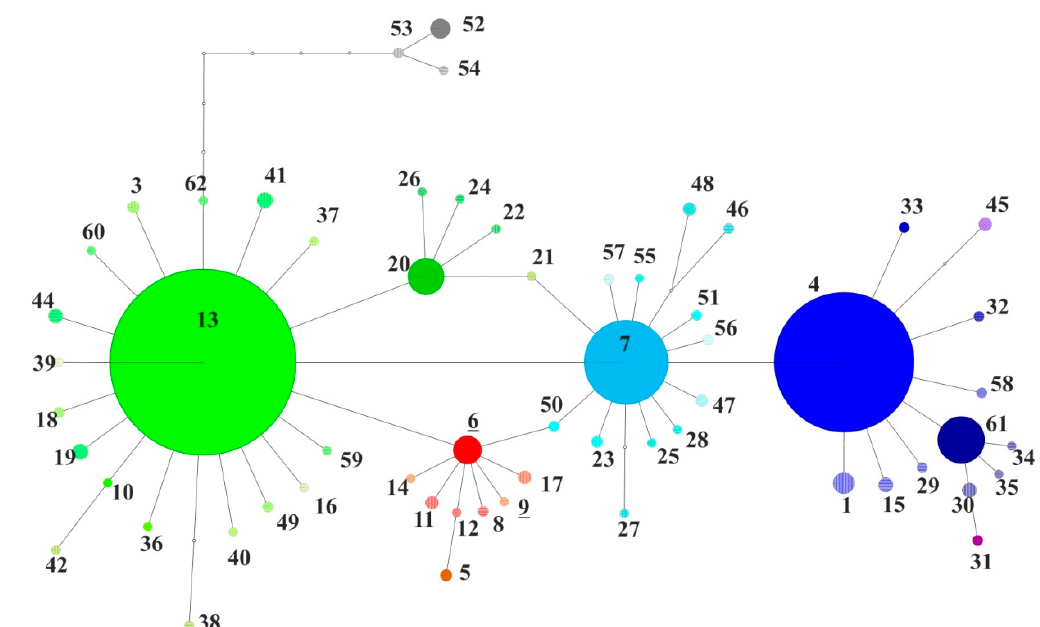
Figure 1. Parsimony network reconstructed by cladistic analysis with 95% connection limit using TCS 1.21. Numbers represent the haplotypes. Dimensions of pies are proportional to frequency, and each haplotype is colored based on its affiliation to a certain clade.